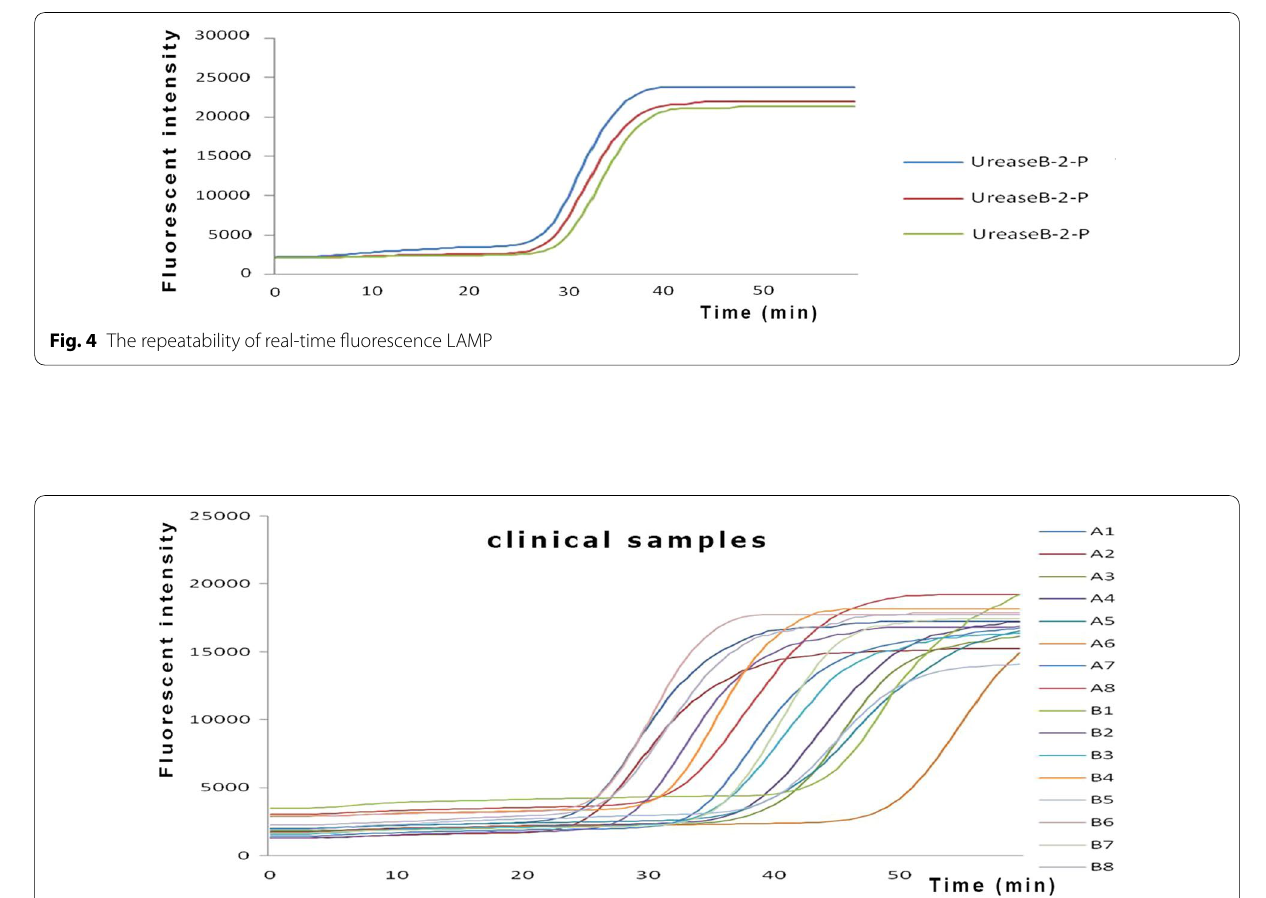
Fig. 5 Detection of common clinical samples by real‑time fluorescence